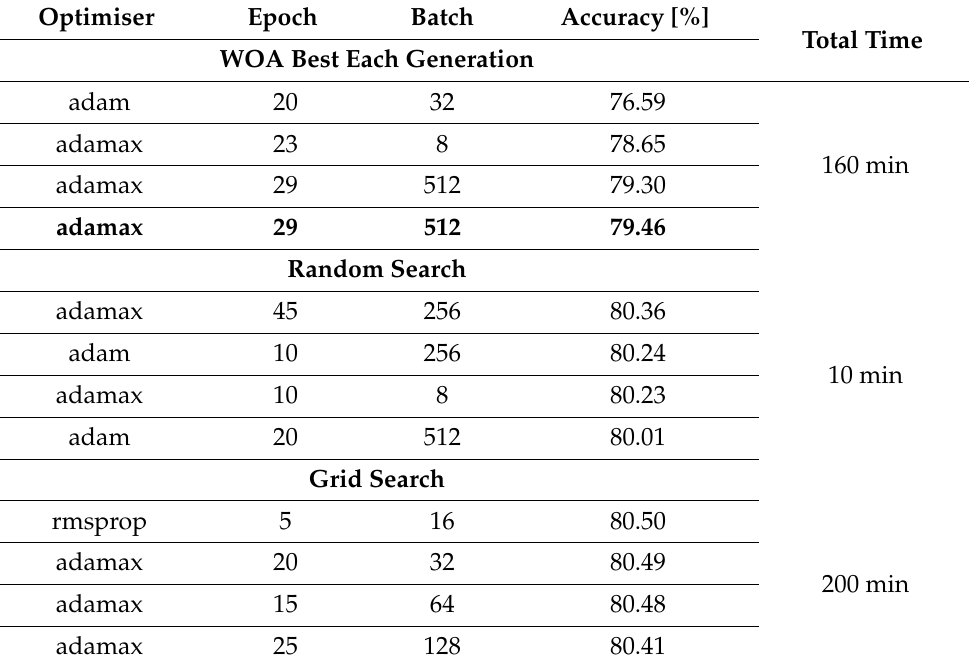
Table 6. Reuters 3D search space, epoch (0–50), discrete optimiser, discrete batch.